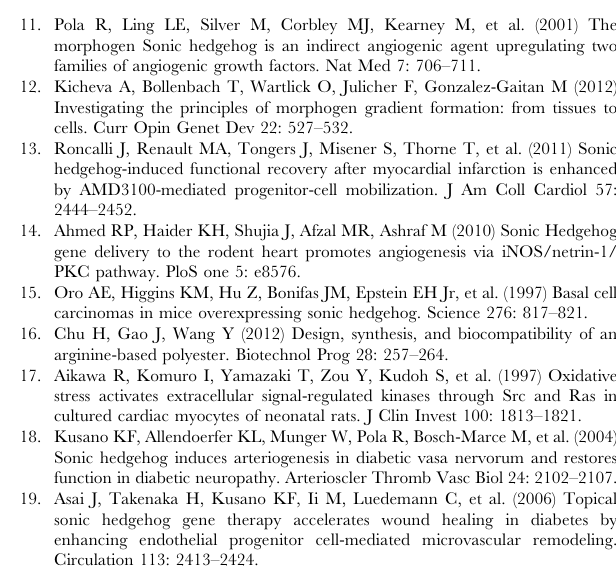
Figure S1 Neonatal rat cardiac cell populations were separated by pre-plate technique. Slow-adhering cardiomy- ocytes did not adhere to the pre-plate while fast-adhering cardiac fibroblasts did adhere. Both populations were immunofluorescent stained for myosin heavy chain (MHC) muscle cell marker (red) and counterstained with DAPI for cell nuclei (blue). Scale bars = 100 m m. (TIF) Video S1 Cardiomyocytes in the – H 2 O 2 control group not receiving any Shh pre-treatment and not treated with H 2 O 2 in the apoptosis assay. (WMV) Video S2 Cardiomyocytes in the Free Shh group pre- treated for 48 h with 500 ng ml 2 1 free Shh protein and then treated with H 2 O 2 for 2 h in the apoptosis assay. (WMV) Video S3 Cardiomyocytes in the Shh coacervate group pre-treated for 48 h with 500 ng ml 2 1 Shh in the coacervate and then treated with H 2 O 2 for 2 h in the apoptosis